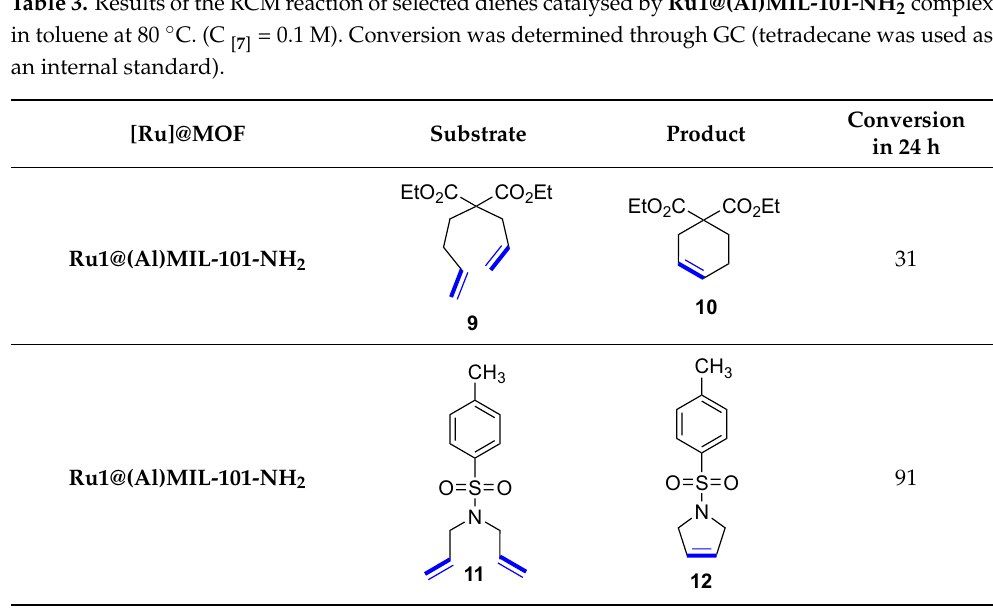
Table 3. Results of the RCM reaction of selected dienes catalysed by Ru1@(Al)MIL-101-NH 2 com- plex in toluene at 80 °C. (C [ 7 ] = 0.1 M). Conversion was determined through GC (tetradecane was used as an internal standard).